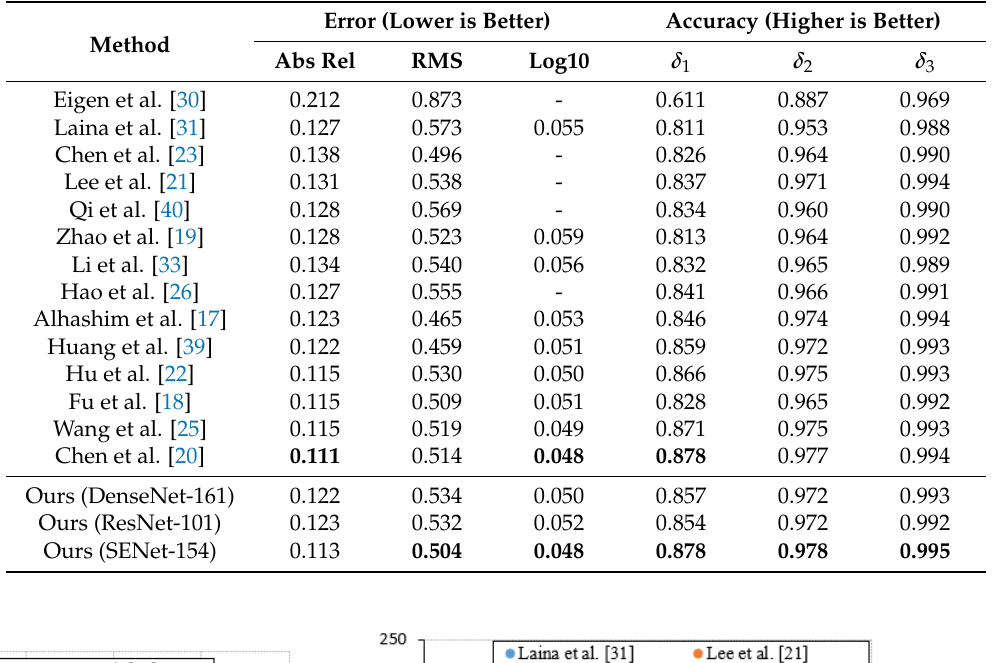
Table 1. Model performance on NYU-Depth-V2. Best scores are highlighted in bold font. The